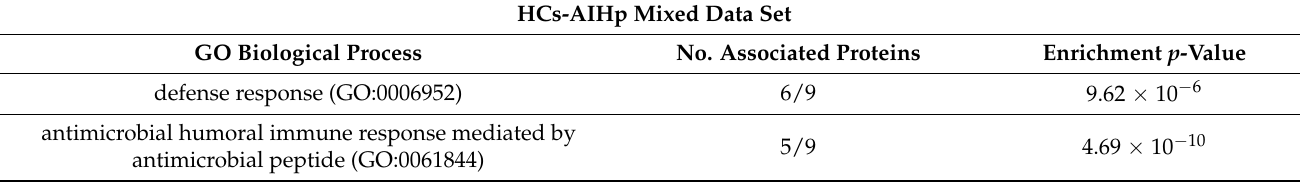
Table 3. GO biological process enrichment of the most discriminant components of HCs-AIHp and HCs-PBCp mixed data sets results by Boruta algorithm. For each group, only the first ten biological processes are shown with the relative p -values and the number of associated proteins in respect to the total number of components (nine for HCs-AIHp and six for HCs-PBCp) used for